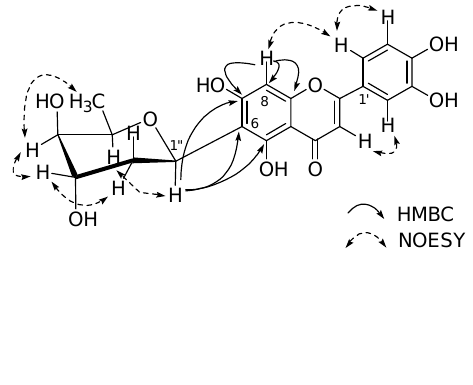
Figure 2. Selected HMBC and NOESY correlations of compound 1